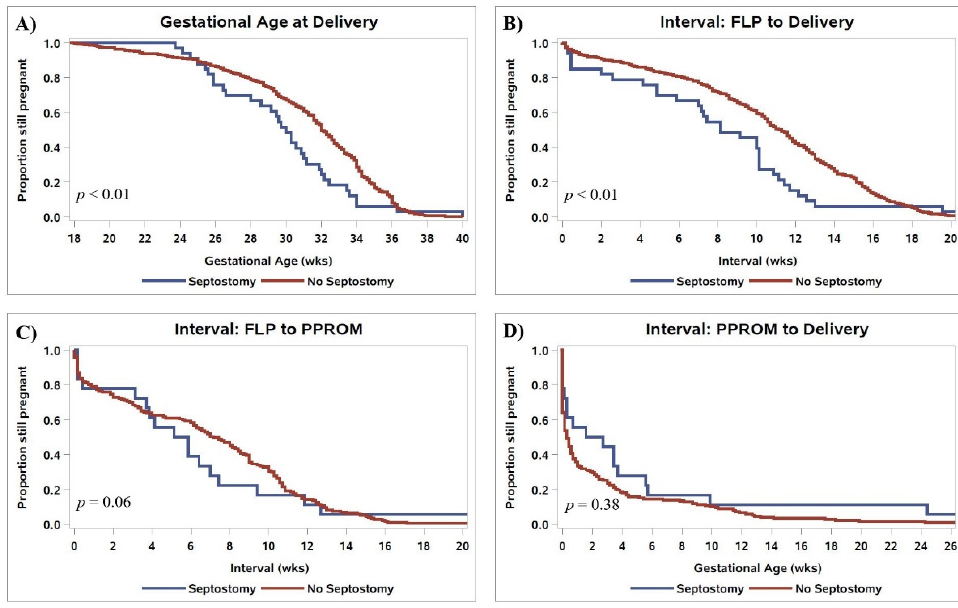
Figure 2. Kaplan–Meier curves comparing ( A ) gestational age of delivery, ( B ) the interval between FLP and delivery, ( C ) the interval from FLP to PPROM, and ( D ) the interval from PPROM to delivery in patients who had vs. did not have IOS. p -values are for log-rank tests comparing survival distributions.